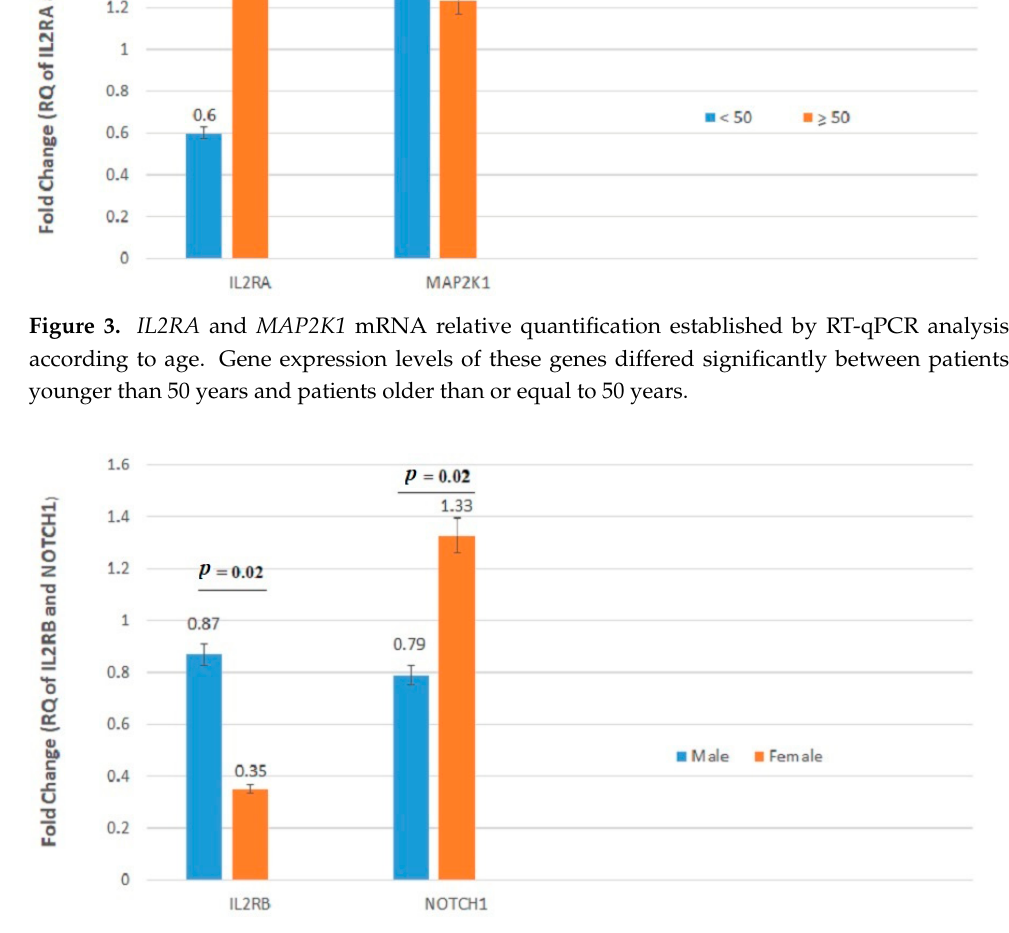
Figure 4. IL2RB and NOTCH1 mRNA relative quantification (RQ) established by RT-qPCR analysis according to gender. Gene expression levels of these genes differed significantly between males and